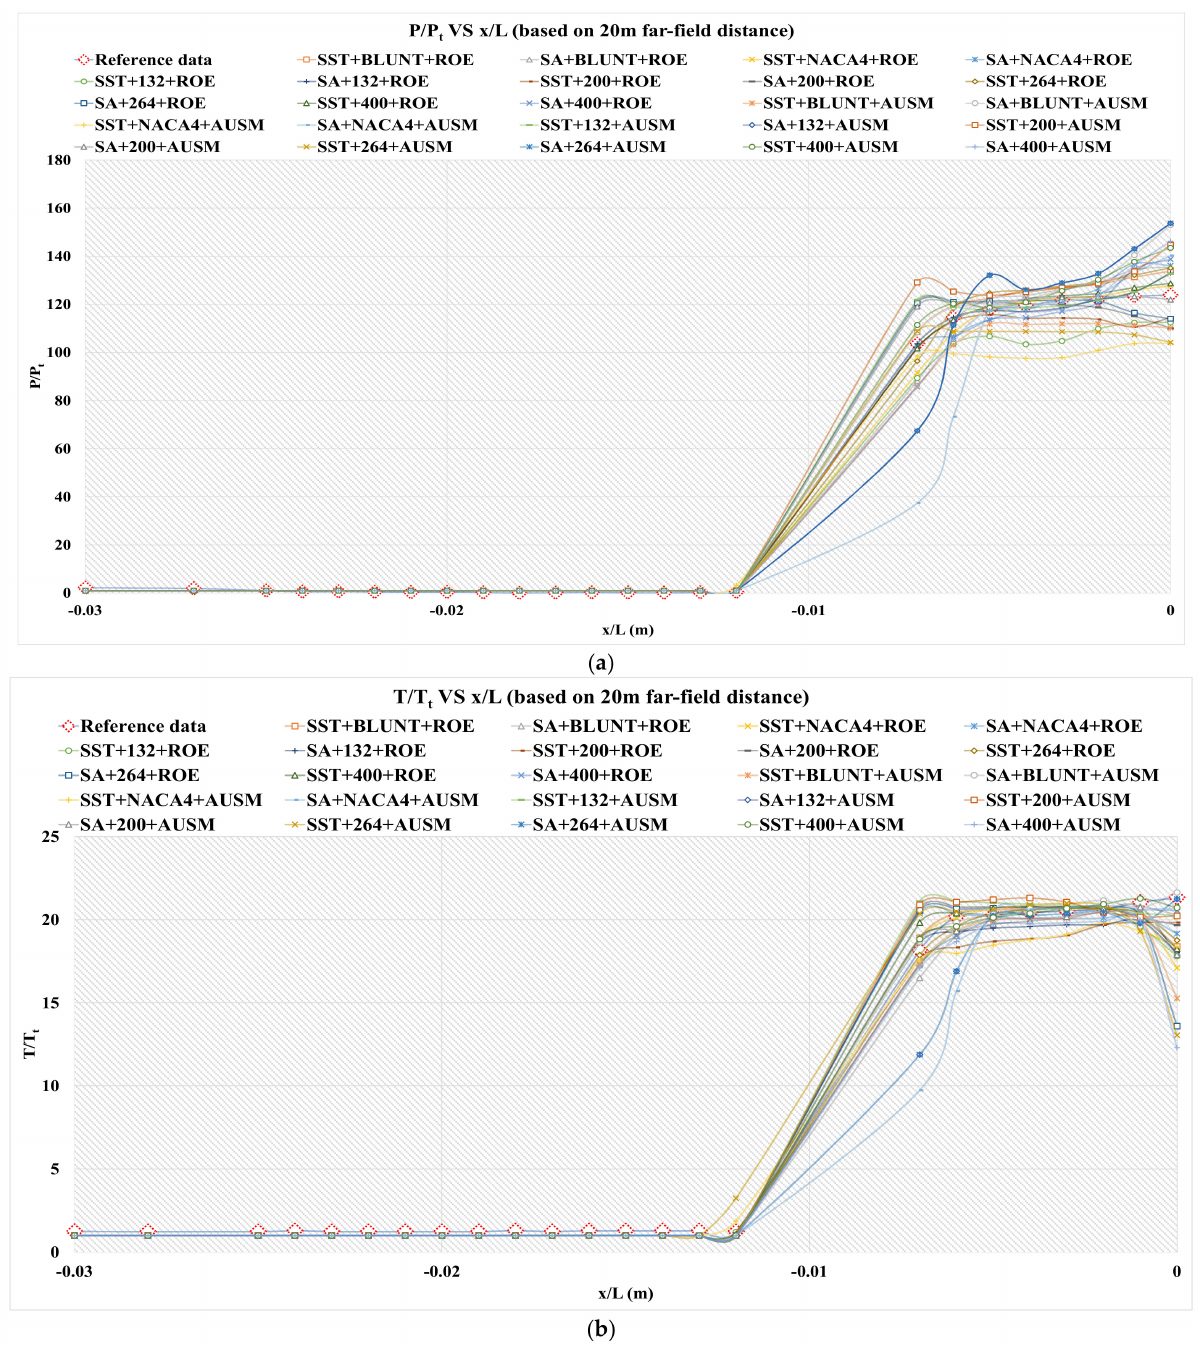
Figure 27. ( a ) Distributions of P/P t of 20 m far-field distance; ( b ) Distributions of T/T t of 20 m far-field